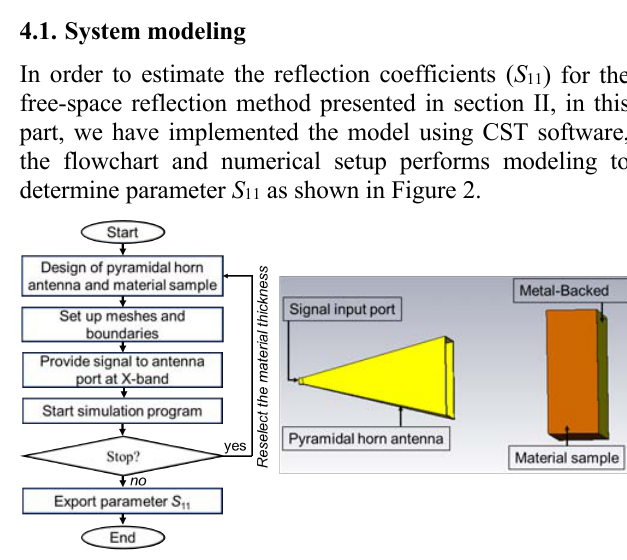
Figure 2: Modeling to determine parameter S 11 : Left (Flowchart) and Right (Numerical setup).